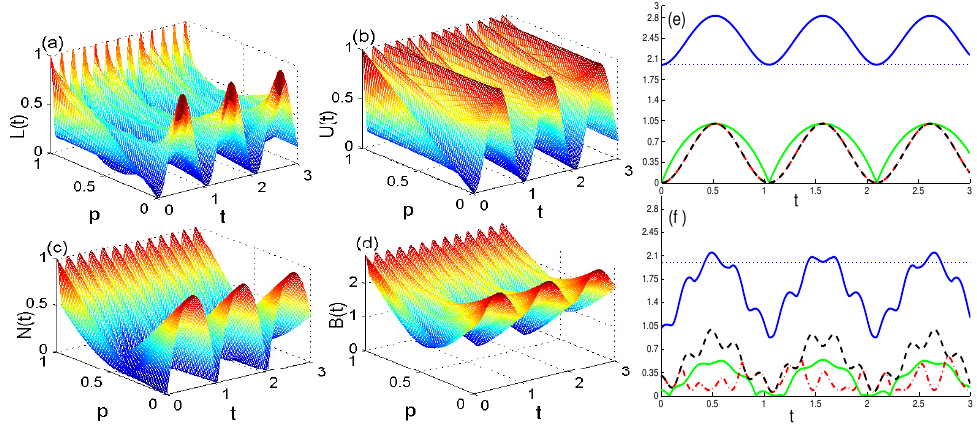
Figure 2. The L ( t ) in ( a ), U ( t ) in ( b ), N ( t ) in ( c ) and B ( t ) in ( d ) as functions of the time and the purity indicator p ∈ [ 0,1 ] for χ z = 3, ∆ = 1.5, J x = J z = 2 and γ = 0.0. The L ( t ) (dashed plots), U ( t ) (dashed dotted plots), B ( t ) (upper solid plots) and N ( t ) (solid plots) for p = 0 in ( e ) and p = 0.3 in ( f